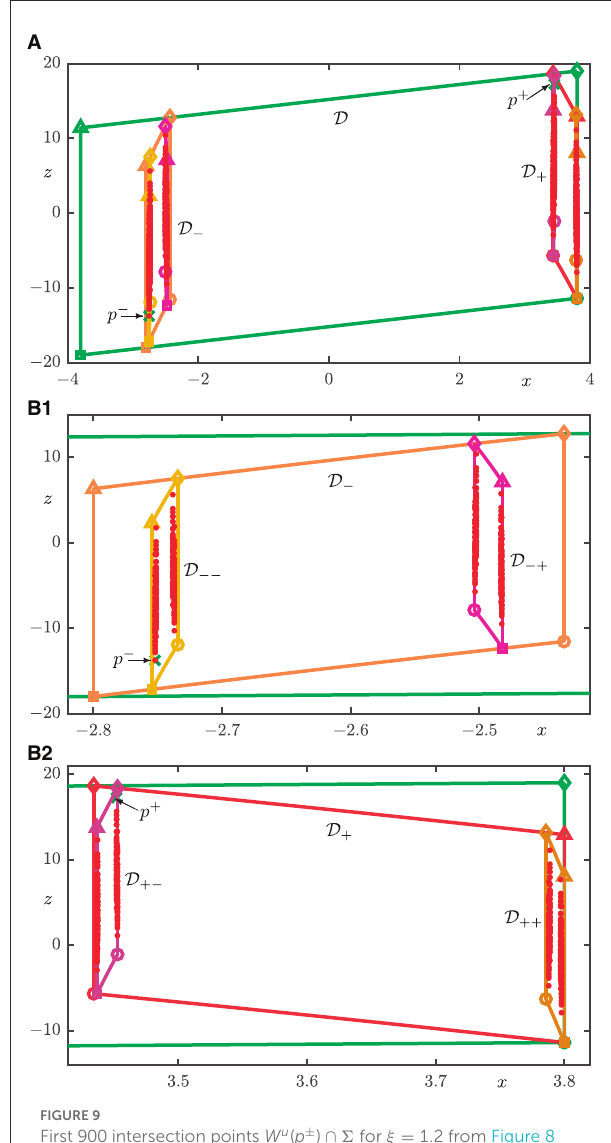
FIGURE9 First 900 intersection points W u ( p ± ) ∩ 6 for ξ = 1.2 from Figure 8 shown together with p ± and the intersection sets of D (green), D − (orange), D + (red), D −− (yellow), D −+ (magenta), D +− (dark magenta), and D ++ (light brown). (A) shows all of 6 ∩ D and (B1, B2) are enlargements of D − and D + ,